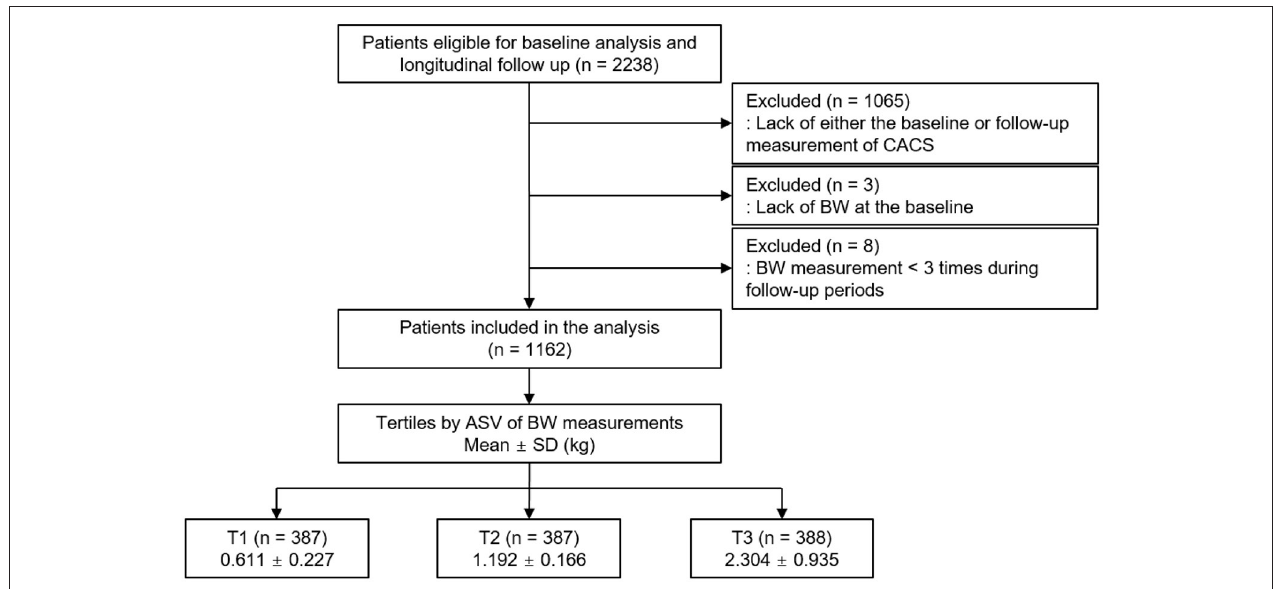
FIGURE 1 | Flow diagram of the study participants. ASV, average successive variability; BW, body weight; CACS, coronary artery calcium score; T1, 1st tertile; T2, 2nd tertile; T3, 3rd